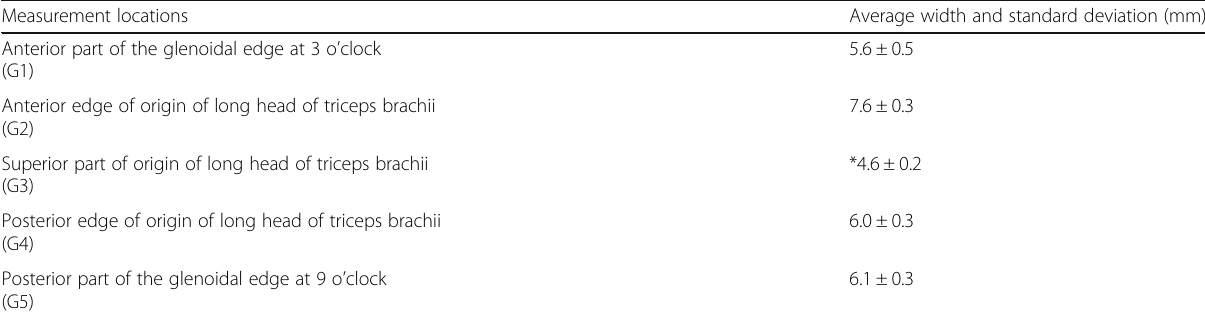
Table 1 Measurements of the glenoidal attachment of the articular capsule Measurement locations